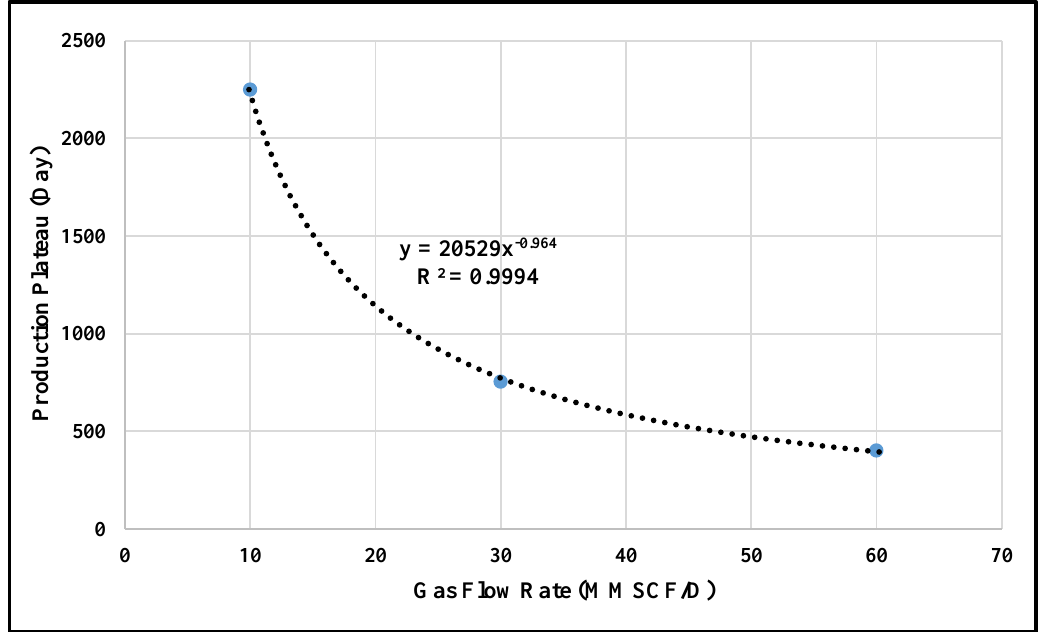
Figure 17. Stabilized production time (production plateau) plotted against gas-production rate.